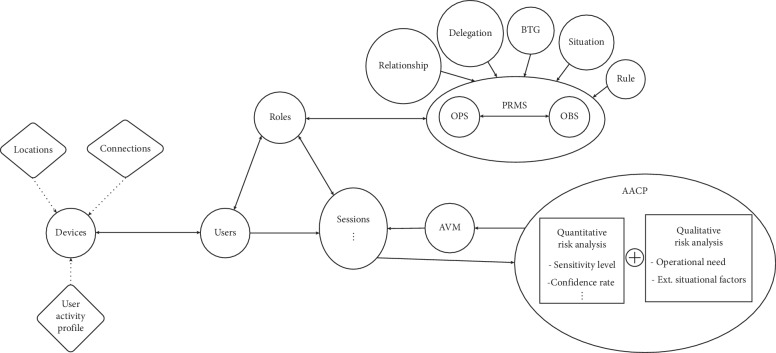
SoTRAACE architecture and components [22].